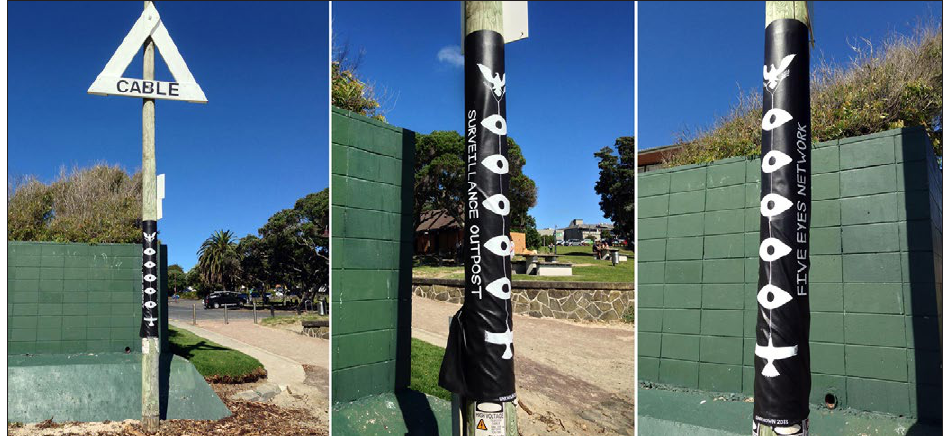
Figure 1: ‘Five Eyes Network – Output’ (image credit: John G. Johnston)